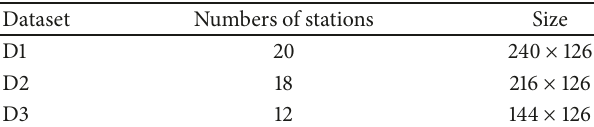
Table 1: Datasets